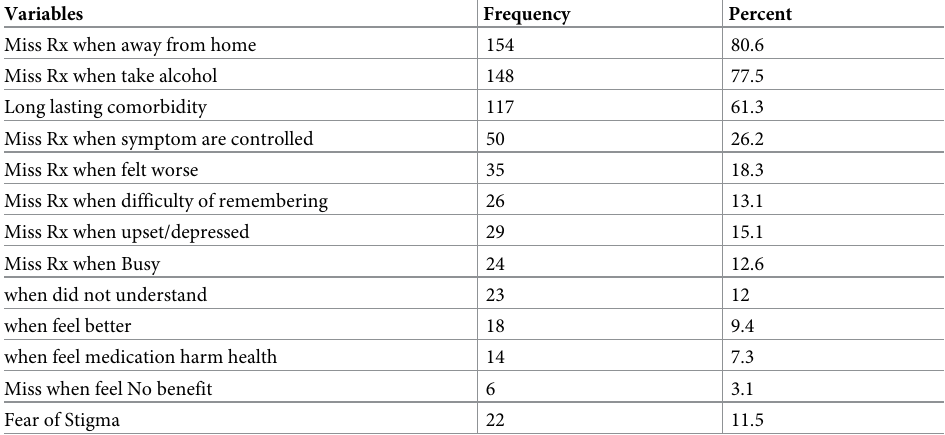
Table 2. Patient related factors for non-adherence to diabetic treatment regimen among T2DM patients who attend the medical referral clinics for treatment and follow up at DURH, 2017. Variables